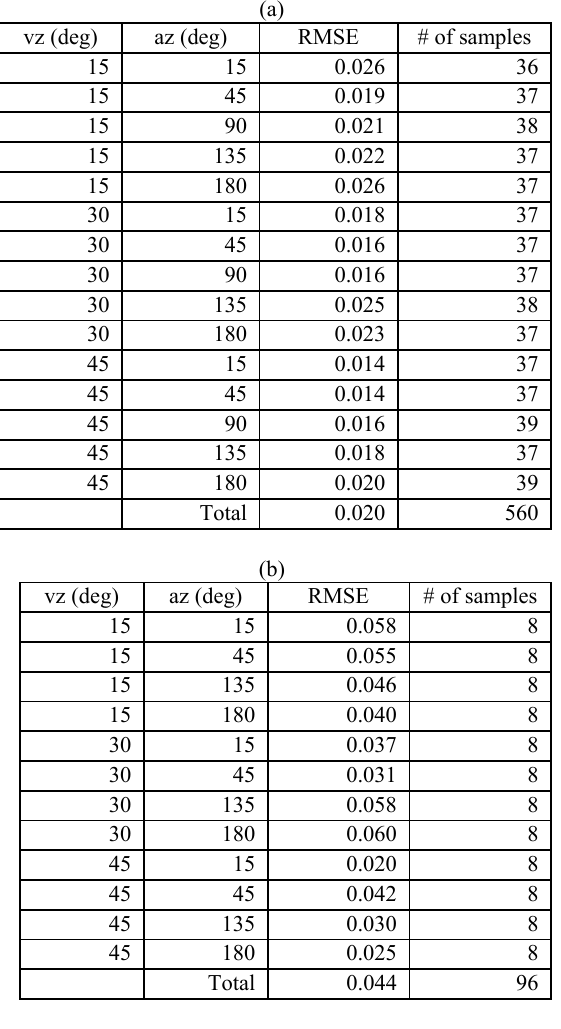
Table 3. Root-mean-square error of estimated albedo. (a) Barren or sparsely vegetated (IGBP LC16). (b) Deciduous broadleaf forest (IGBP LC4). “vz” and “az” are sensor zenith angle and relative azimuth angle, respectively.